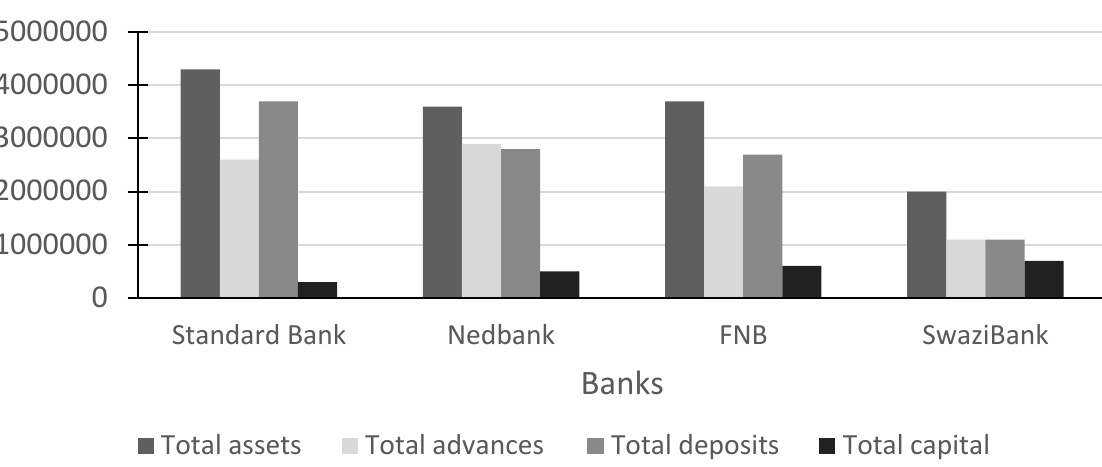
Figure 2. Swaziland banking industry by total assets, total advances, total deposits and total capital